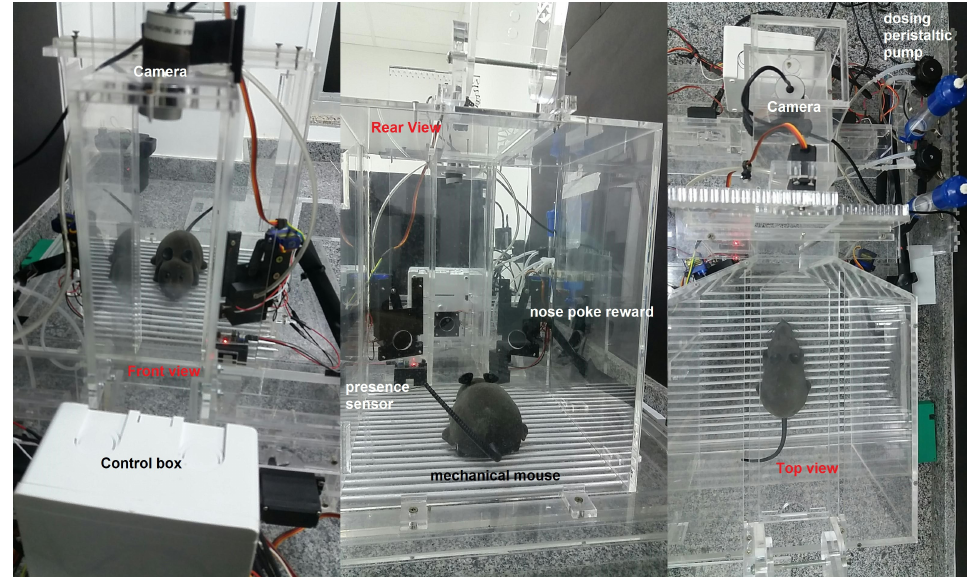
Figure 20. Remote control mouse inside the behavior box.